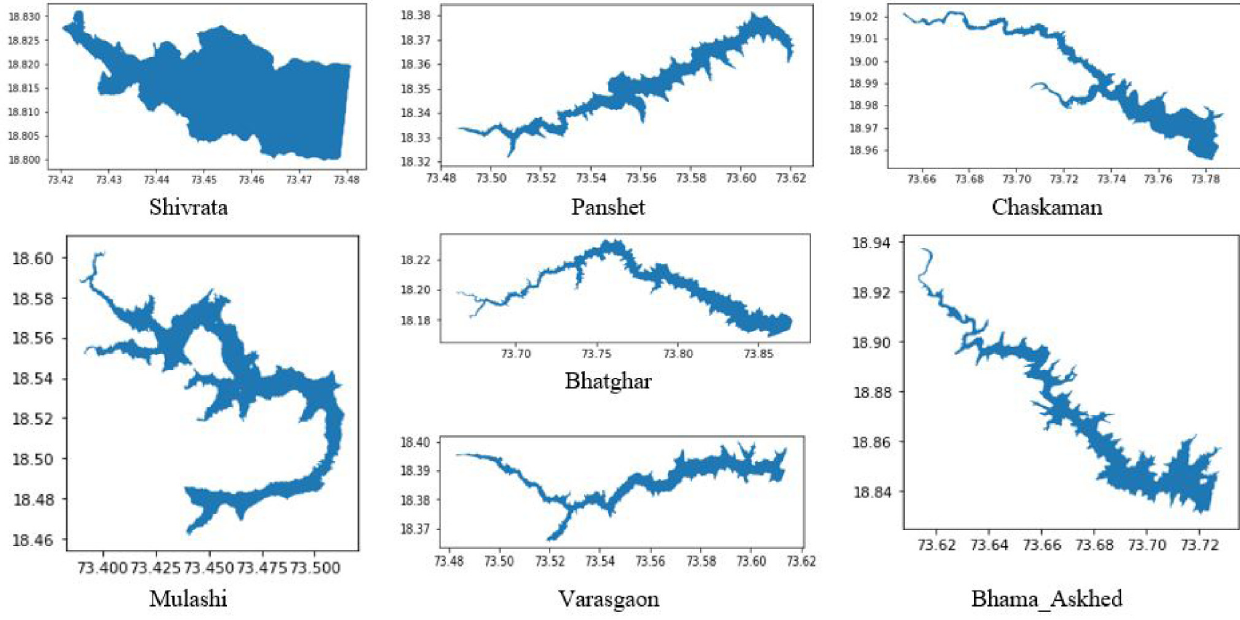
Figure 9. Identified reservoirs location and